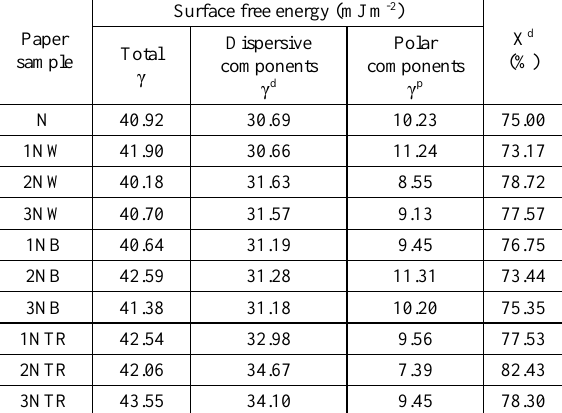
Table 6. Surface free energy and